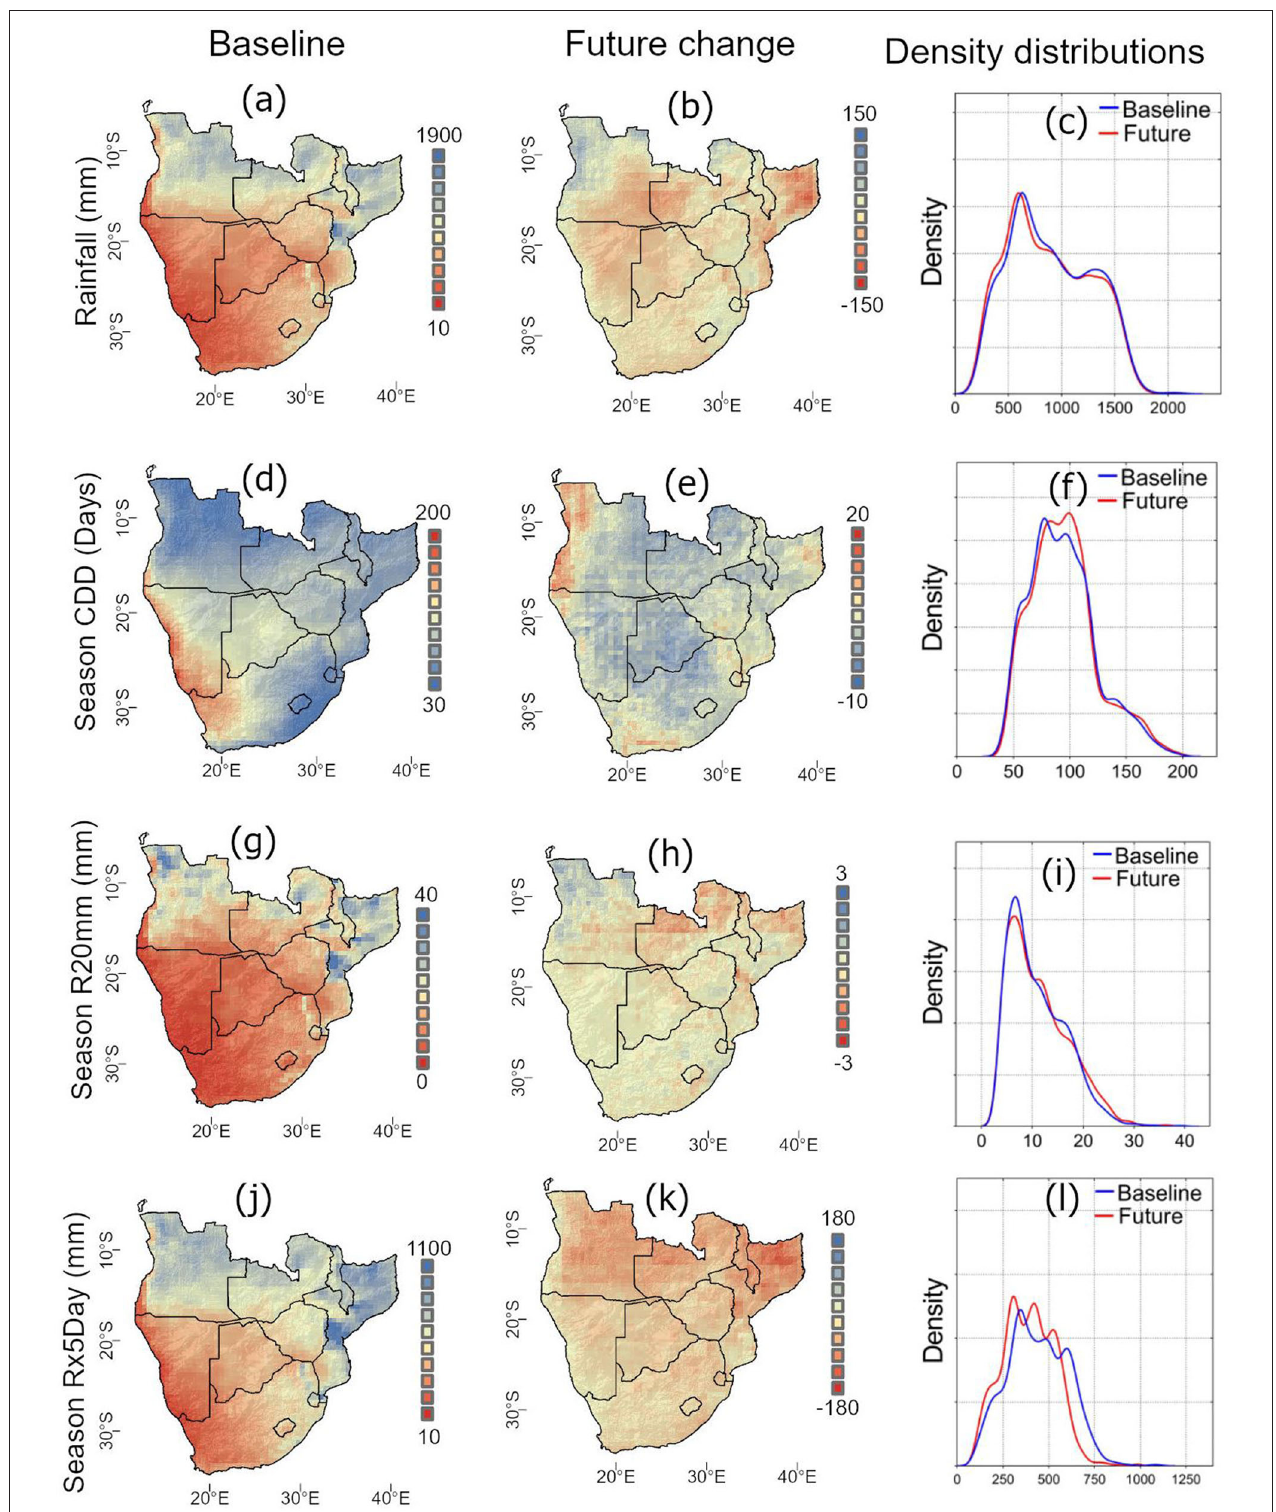
FIGURE 2 | The distribution of precipitation and precipitation indices under baseline and projected climate conditions for the agricultural season (October to April) over Southern Africa. First, second, third and fourth row show total precipitation, consecutive dry days (CDD), count of days when rainfall ≥ 20mm (R20mm), and maximum consecutive 5-day precipitation (Rx5Day), respectively. The first column present the baseline period (1986–2014) and the second column show the changes in the future period (2036–2064) relative to the baseline. The third column show the area density plots to indicate the changes in area between the two climate periods.